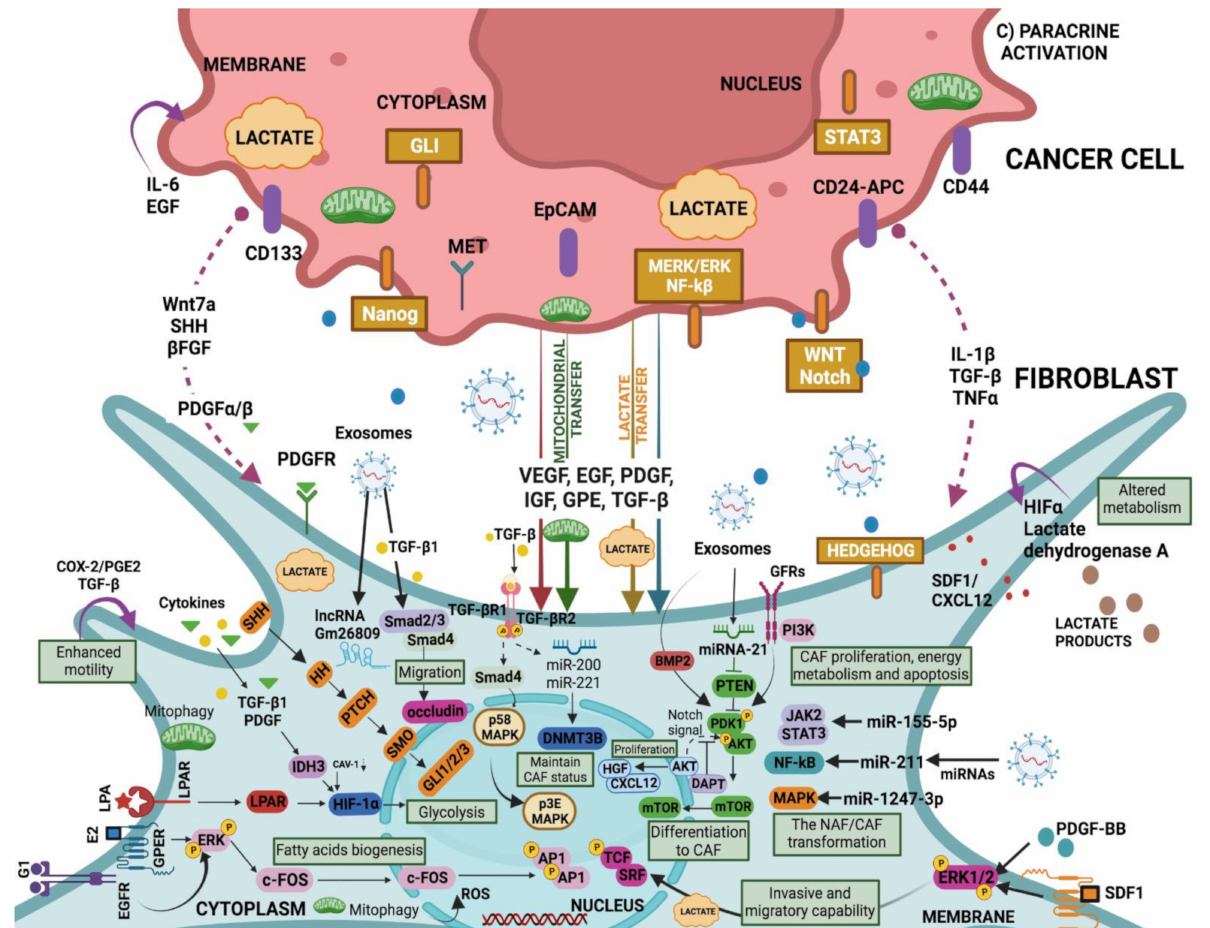
Figure 3. CAF “education” by the cancer-derived factors (extension of section C) in Figure 2). Cancer- derived exosomes carry elements such as miRNA and lncRNA that promote the transformation of NAF to CAF through downstream signals that include cascades such as TGF- β /Smads, JAK/STAT, NF- κ B, and MAPK. NAF-CAF conversion may also be driven by the reprogramming of glucose metabolism and the HIF-1 α signalling pathway involved in glycolysis. Both the canonical TGF- β signalling pathway (TGF- β /Smads) and the non-canonical pathway (with activation of TGF- β but not Smads) are actively involved in the malignancy of NAFs. In CAFs, while miRNA-21 can attenuate the inhibition of PTEN on PDK1/AKT, the receptor–ligand binding-activated PI3K can promote it. As a result, through the PDK1/AKT signalling cascade mTOR protein is transported into the nuclei, and subsequently, the mTOR protein regulates the expression of targeted genes associated with CAFs differentiation. Notch signalling pathway is also involved in CAF differentiation via AKT. In turn, CAF-mediated PI3K/AKT signalling pathway regulates cell proliferation, migration, and stemness in cancer cells. EGFR/ERK signalling in CAFs is stimulated by E2 and G1 and upregulates fatty acids metabolism. Further, PDGF-BB and SDF-1 stimulate a higher invasive and migratory capability of CAFs via ERK1/2 phosphorylation (Table